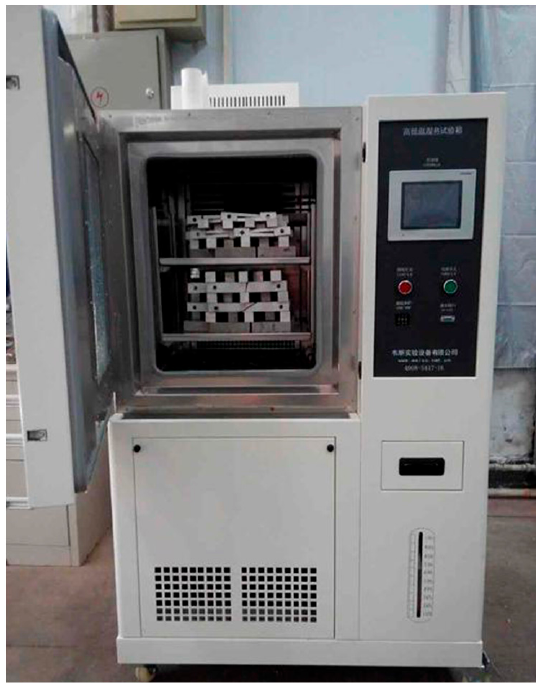
Figure 7. High- and low-temperature hygrothermal cycle experimental chamber.